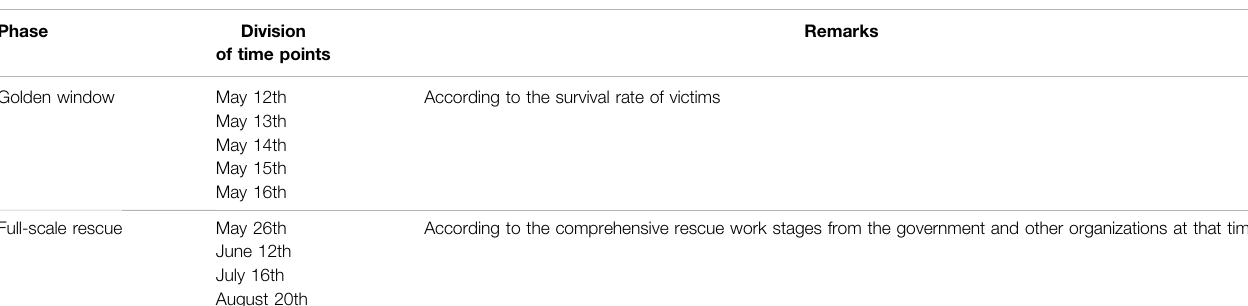
TABLE 1 | Division of time points for highway network